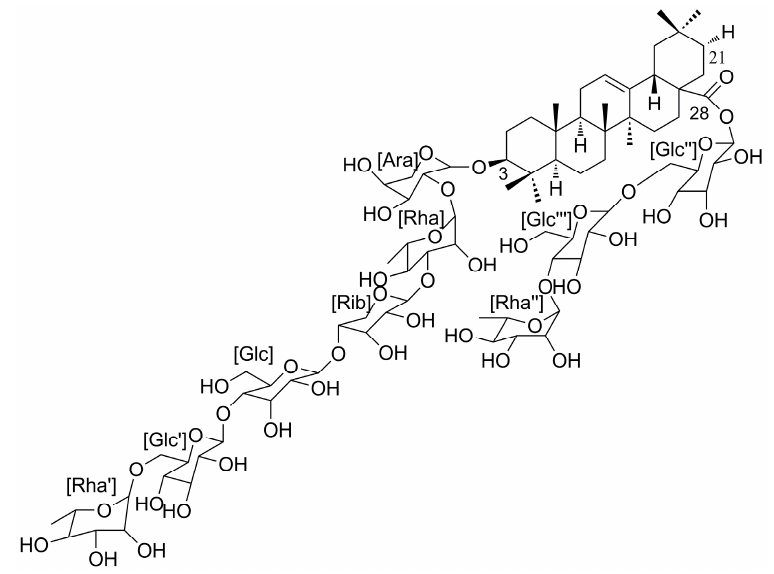
Figure 1. Chemical structure of clematichinenoside (AR).